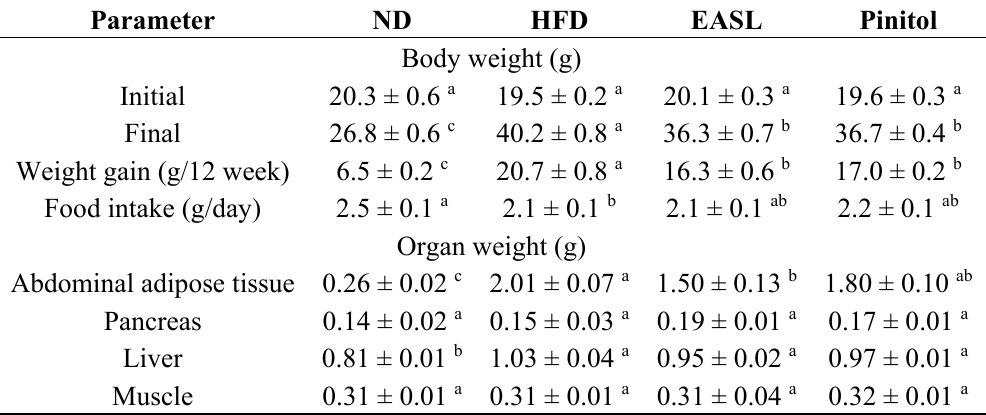
Table 1. Effects of EASL supplementation on body weight gain and organ